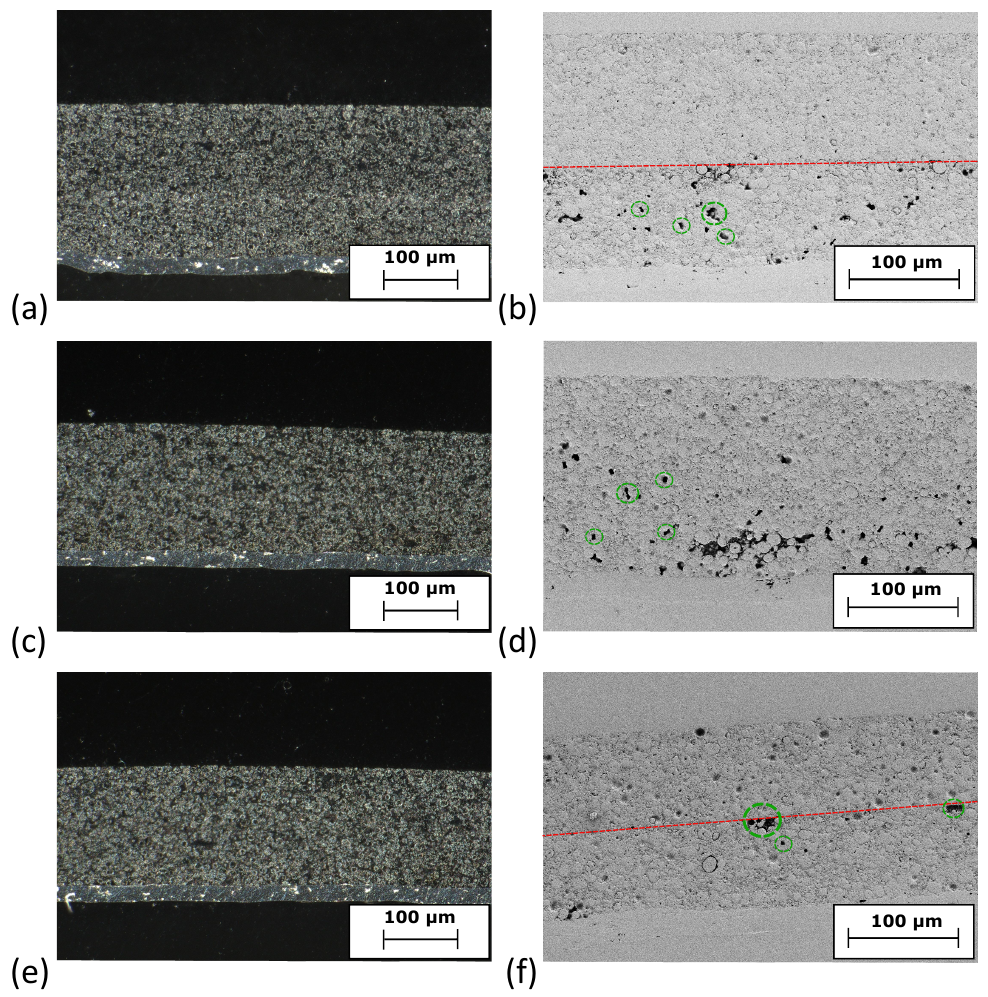
Figure A3. Cross-section images of ( a , b ) 0PMA, ( c , d ) 25PMA and ( e , f ) 50PMA. The left column shows images taken via digital microscope. The right column shows SEM images. Dotted red lines indicate the interface of the two layers, while green circles highlight examples for